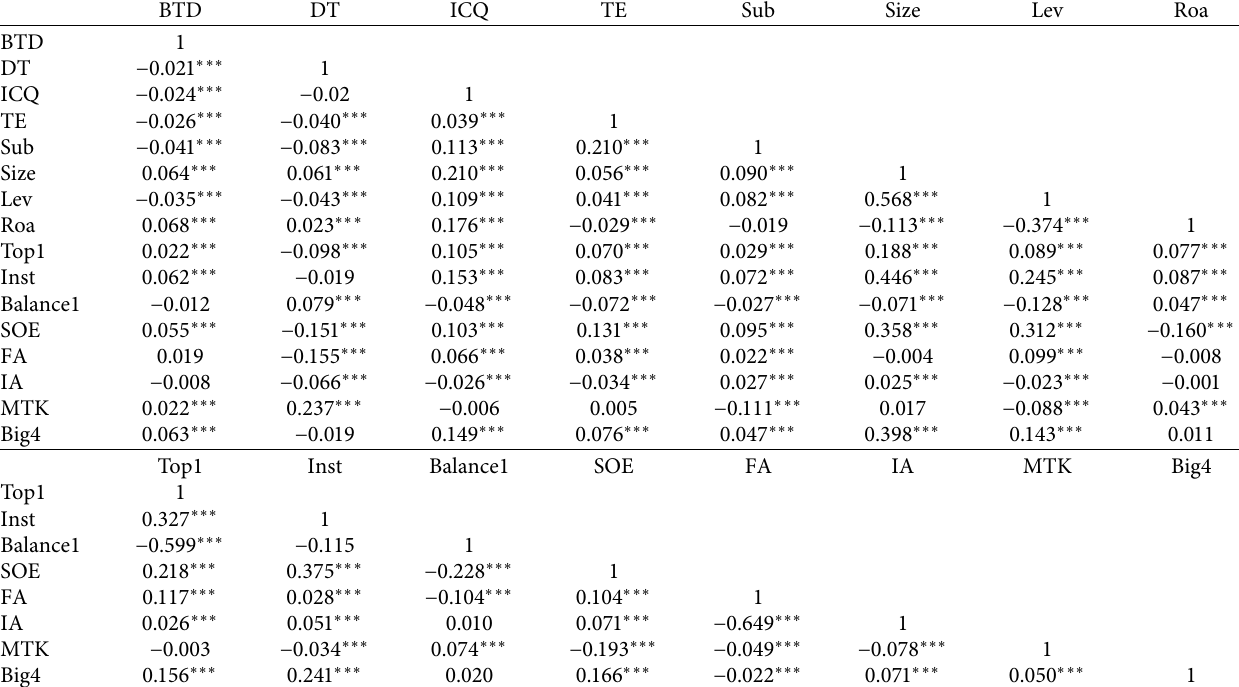
Table 3: Correlation